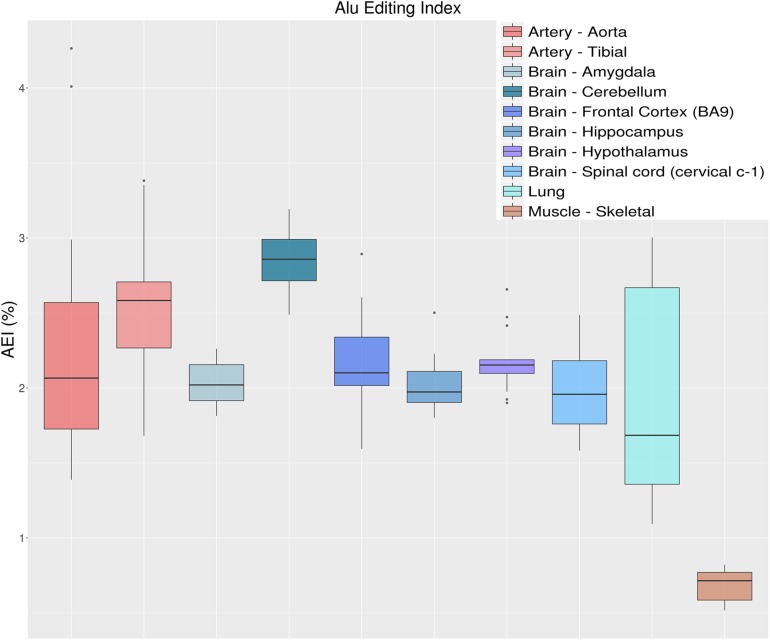
Distributions of Alu editing index (AEI) values over 10 selected tissue types from the GTEx project. AEI represents the weighted average editing level across all expressed Alu sequences. Distributions are presented as box-plots. AEI clearly recapitulates the same trend as overall editing thus confirming that the sites in Alu regions are those that have the greatest impact on the global editing activity.